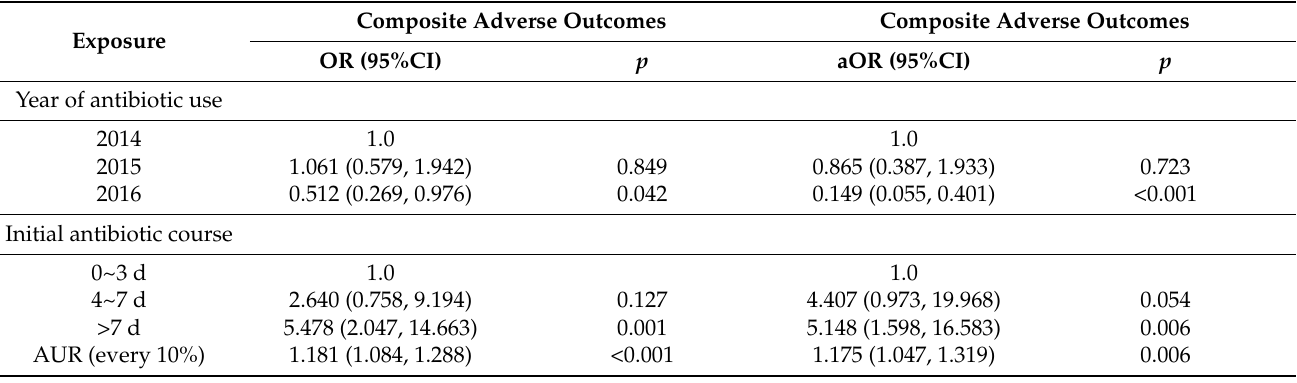
Table 3. Logistic Regression